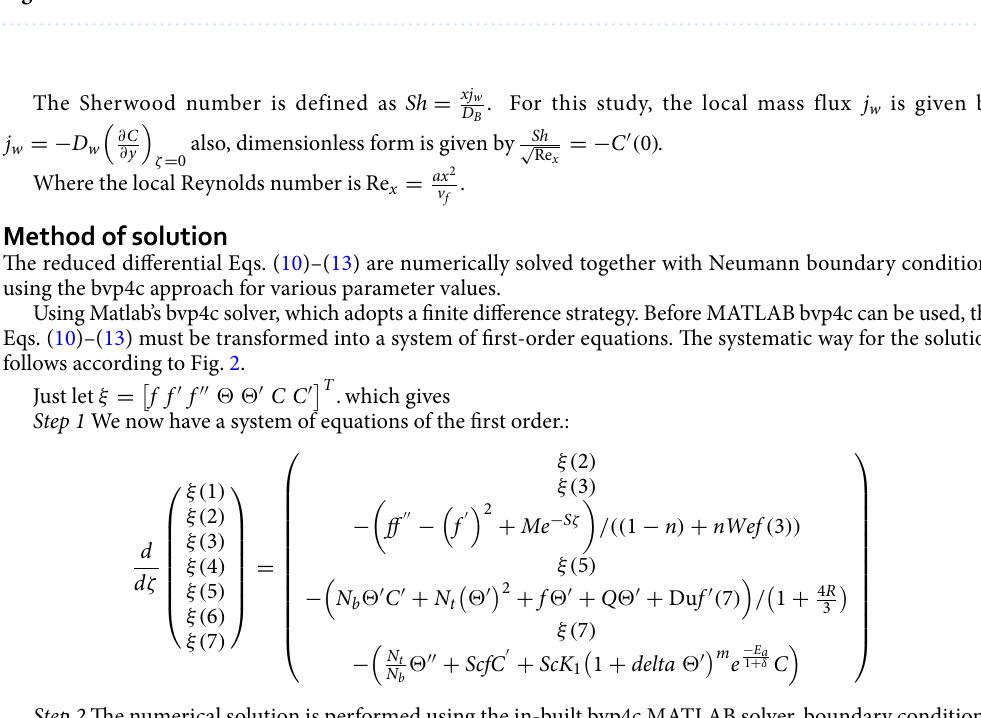
Figure 2. Flow chart